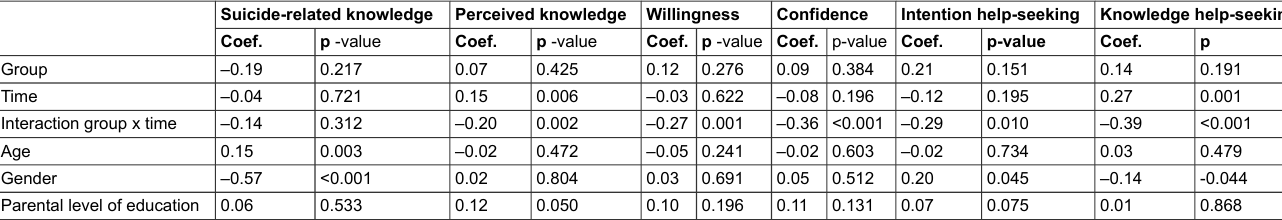
Table 3: Mixed-effect models for efficacy outcomes.